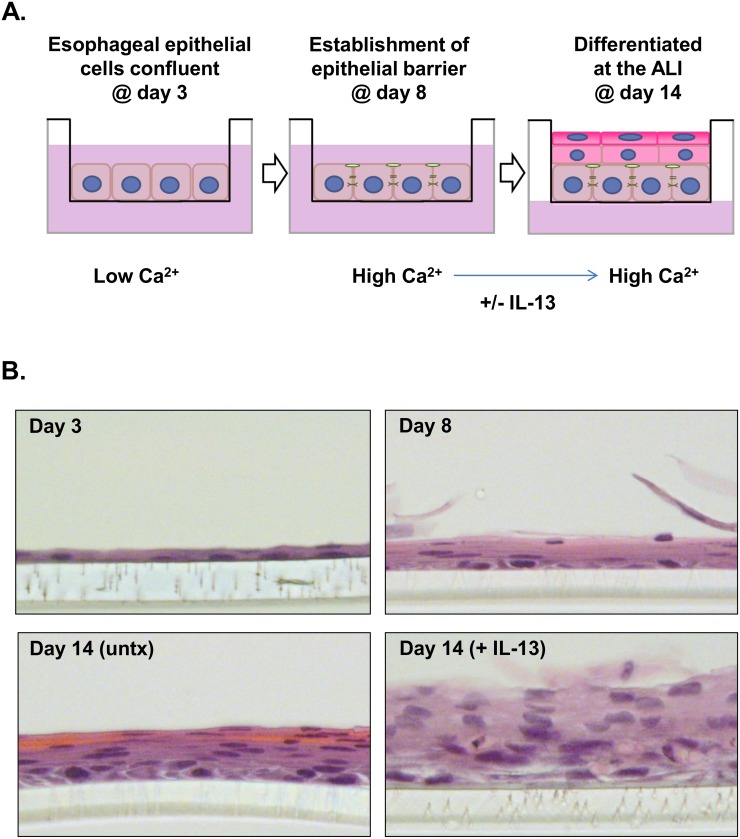
The ALI culture system.Schematic diagram depicting the air-liquid interface (ALI) culturing protocol (A). Representative images (40X) of hematoxylin- and eosin-stained sections at various time points and/or treatments during the ALI protocol (B). The clear semi-permeable membrane can be seen in the bottom of all images. Untx, untreated.